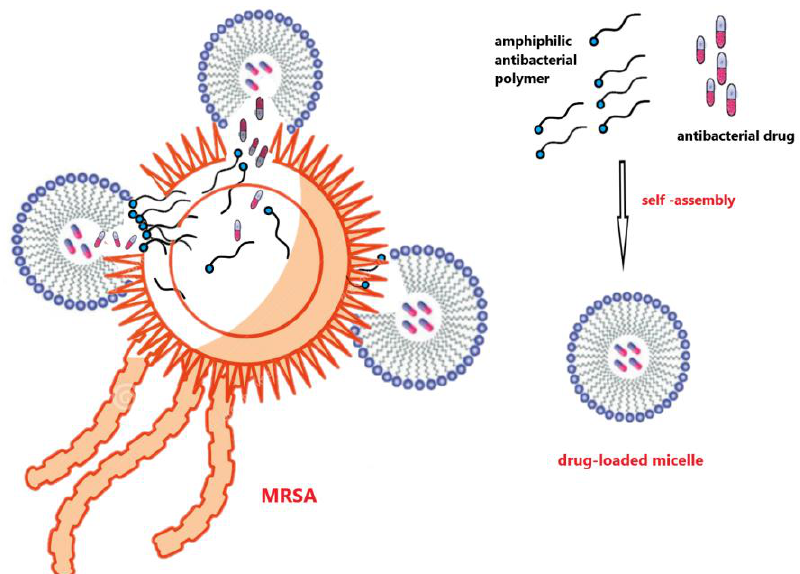
Figure 25. Action mechanism of the antibiotic-loaded micellar particles formed with antibacterial amphiphilic polymer for the elimination of MRSA.